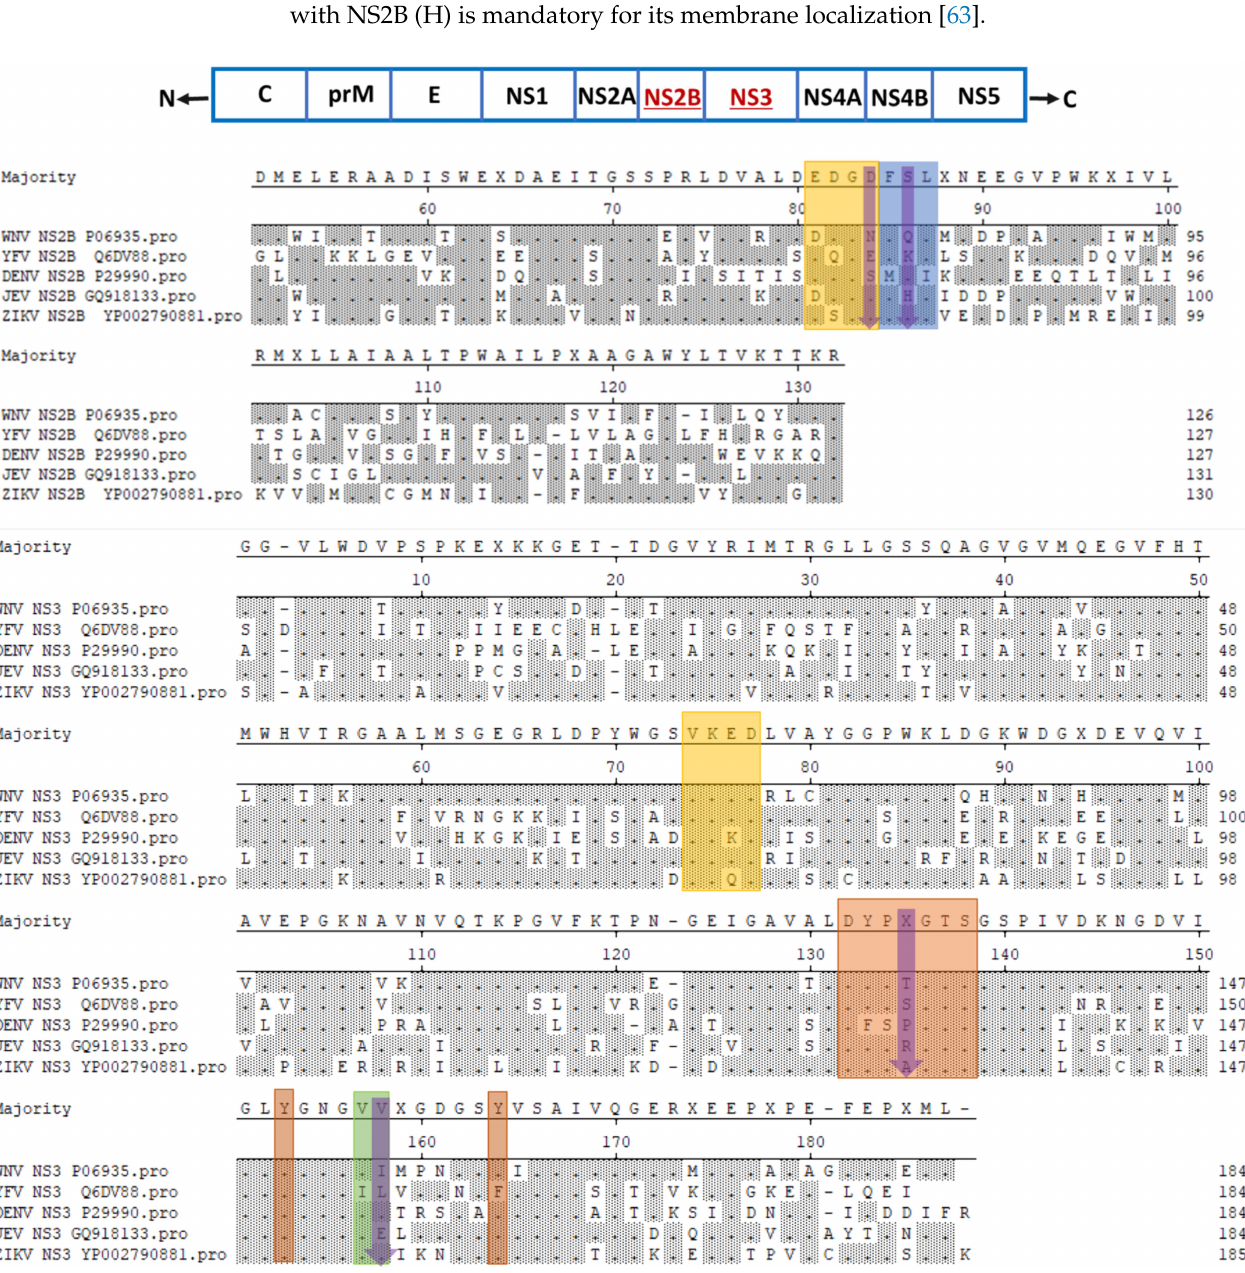
Figure 2. Multiple sequence alignment of NS2B/NS3 protease from different flaviviruses (WNV, YFV, DENV2, JEV, and ZIKV). Residues located in four distinct substrate-binding pockets, i.e., S1, S2, S3, and S4, marked in orange, yellow, cyan, and green, respectively [55,74]. Nonconserved residues located at the binding pockets are marked in magenta arrowheads